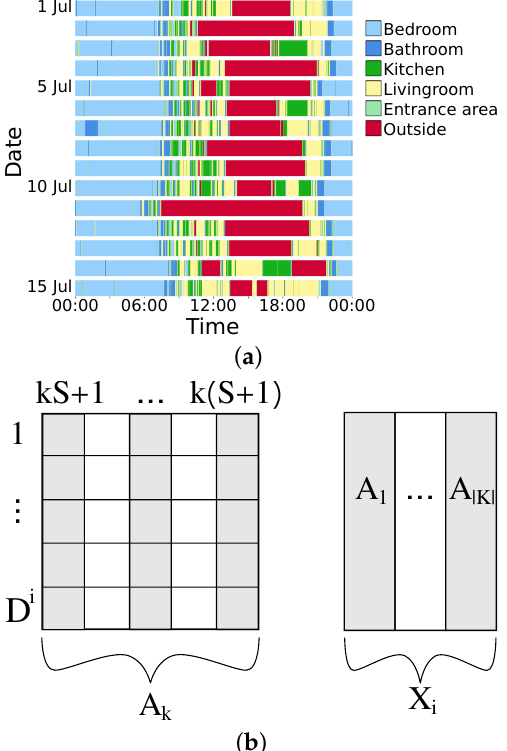
Figure 1. In ( a ) a representation of multiple days is shown, with different room locations colour coded. In ( b ), the structure of matrix X i is explained. Along the columns, sub-matrices A k are stacked. Every sub-matrix A k contains the presence percentages of location k . Its width is S and its height is D i , the total measurement days of person i . The total matrix X i consists of the horizontally stacked matrices A k